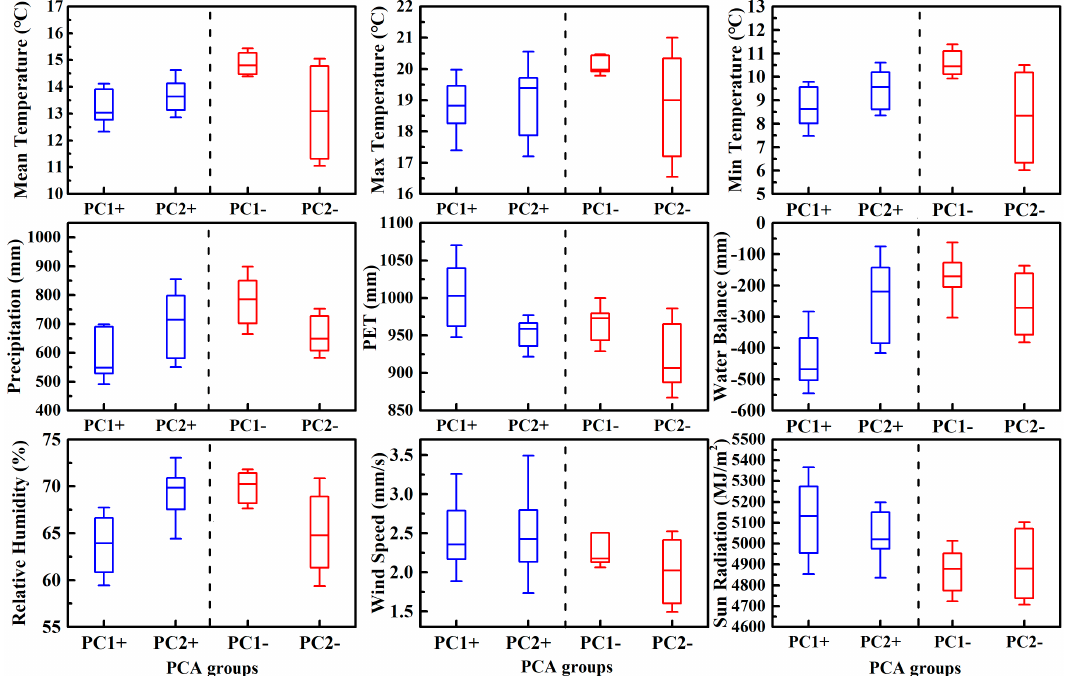
Figure 11. Mean annual values of the main climatic factors characterized by the first two principal components of the winter wheat responses to different time ‐ scale droughts obtained in a PCA method. Error bars represent 1 standard error of the mean value.